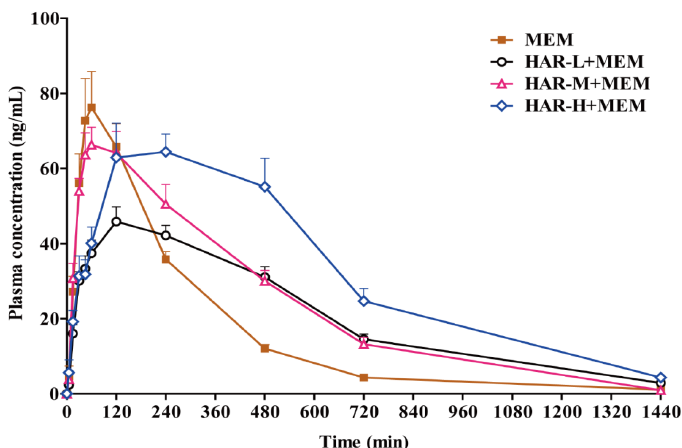
Figure 3. Mean plasma concentration time curves of MEM in rats plasma after single administration of MEM at a dose of 5.0 mg/kg and oral administration of low (20.0 mg/kg), medium (40.0 mg/kg) and high (80.0 mg/kg) doses of HAR combined with MEM (5.0 mg/kg) (n = 8, mean ± SEM).